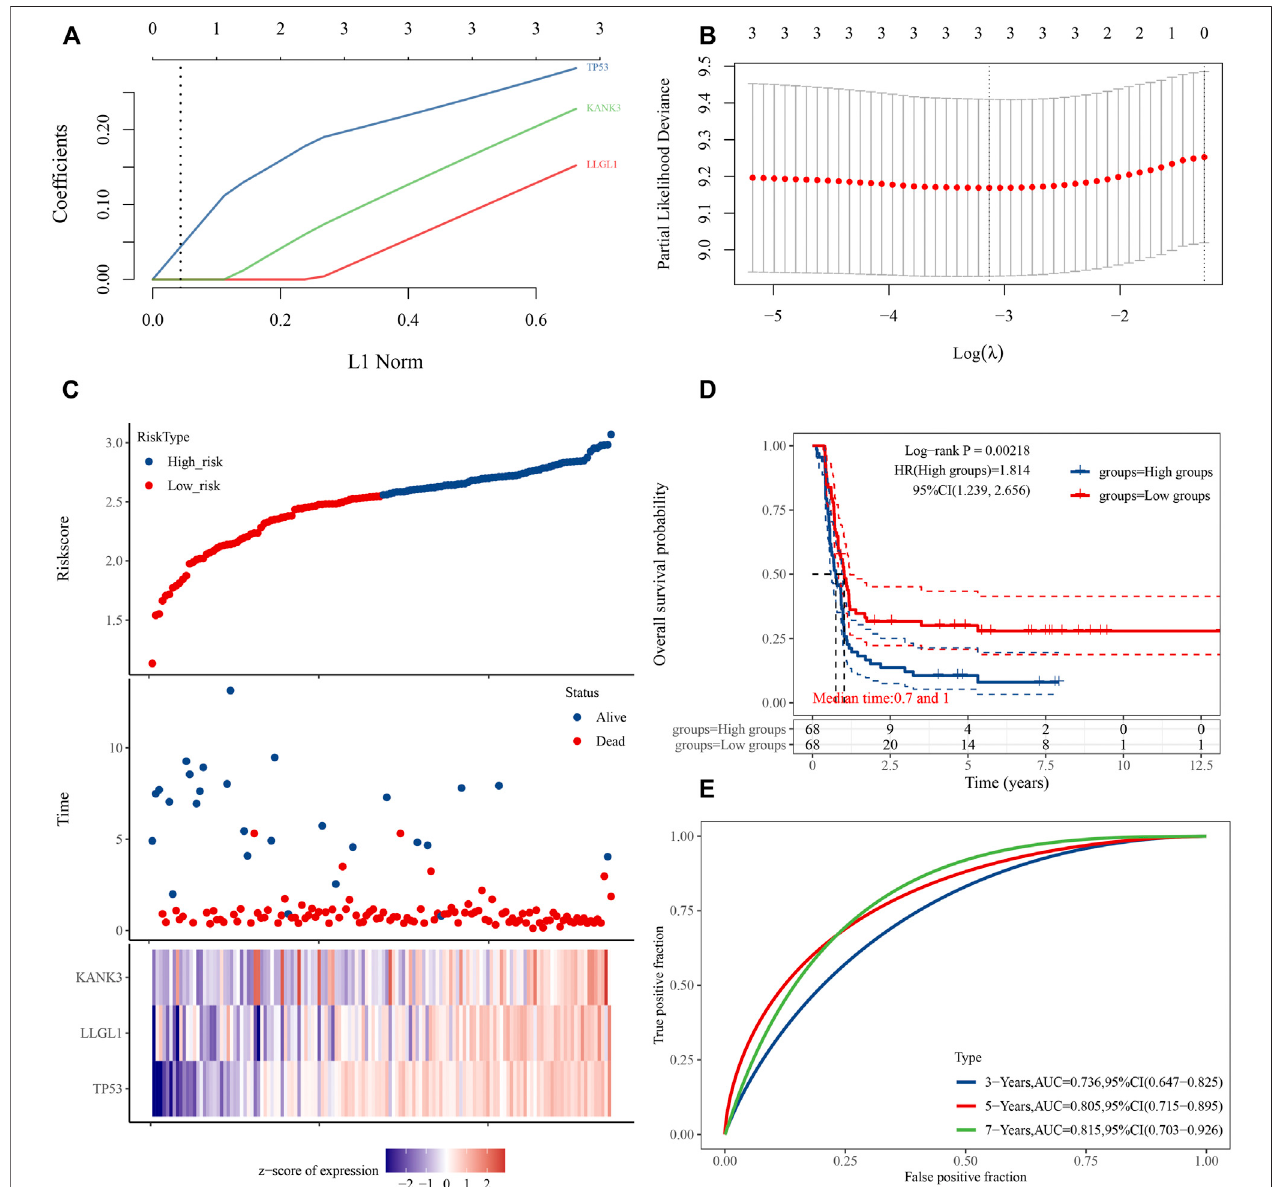
FIGURE8| Establishmentofathree-geneprognosticsignatureregulatedbytheceRNAmechanism. (A) LASSOcoef fi cientpro fi lesofthe3prognosticDE-mRNAs within the subnetwork. (B) LASSO deviance pro fi les of the 3 prognostic DE-mRNAs within the subnetwork. (C) Risk score distribution and survival status for each patient,andexpressionheatmapofthreegenescorrespondingtoeachsampleabove. (D) Comparisonofprognosticdifferencesbetweenthehigh-andlow-riskgroups divided by signature model. (E) Evaluation ef fi cacy of the signature model at 3, 5, and 7 years. Area under the curve is 0.736, 0.805, and 0.815, respectively.